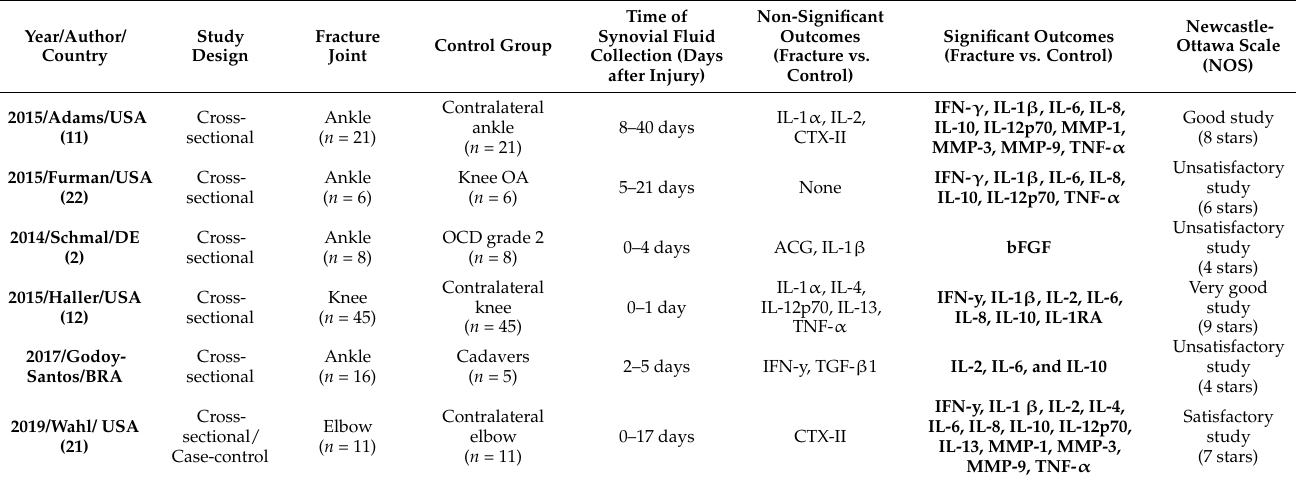
Table 1. Demographics and Results of the Included Studies ( n =